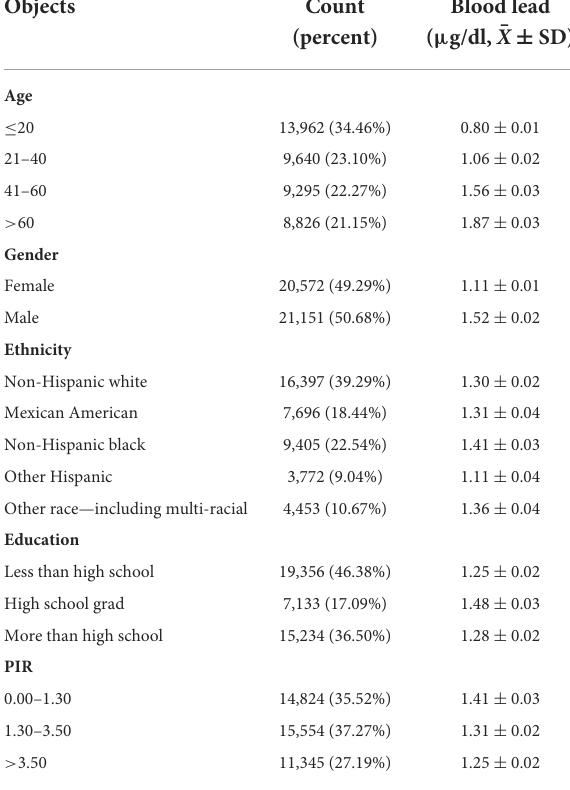
TABLE 1 Mean blood lead concentration for age, gender, ethnic, education, and PIR group.